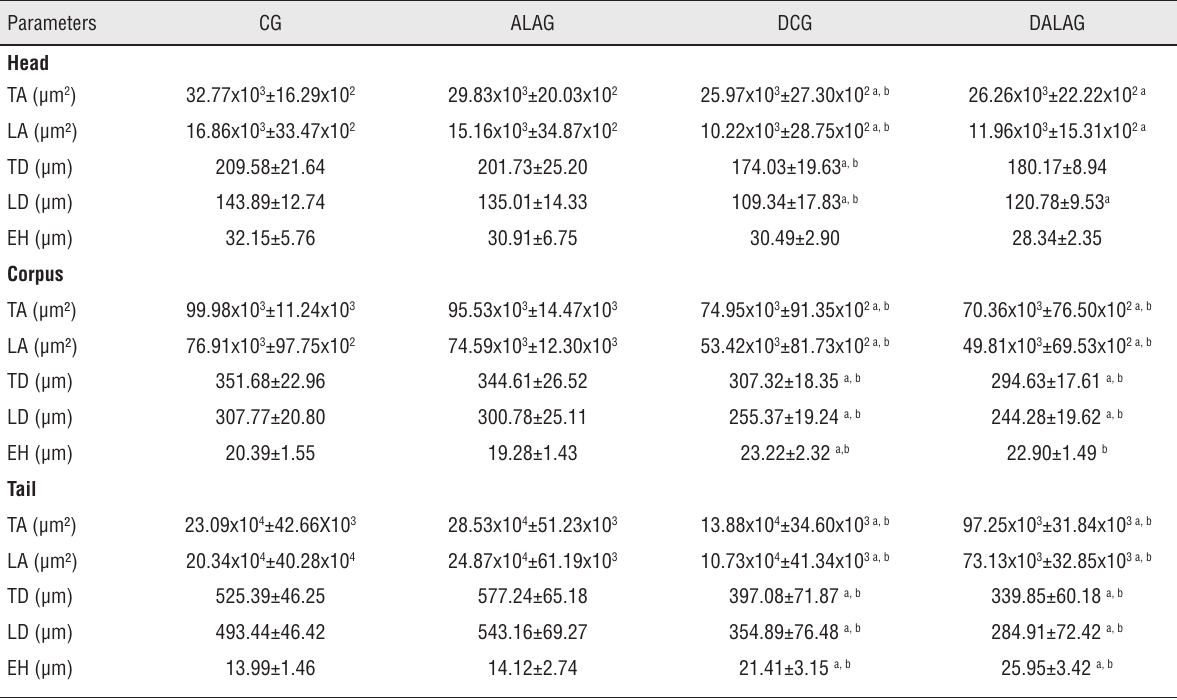
Table 3 - Histomorphometric analysis of epididymal tubules - head, body and tail. Parameters CG ALAG DCG